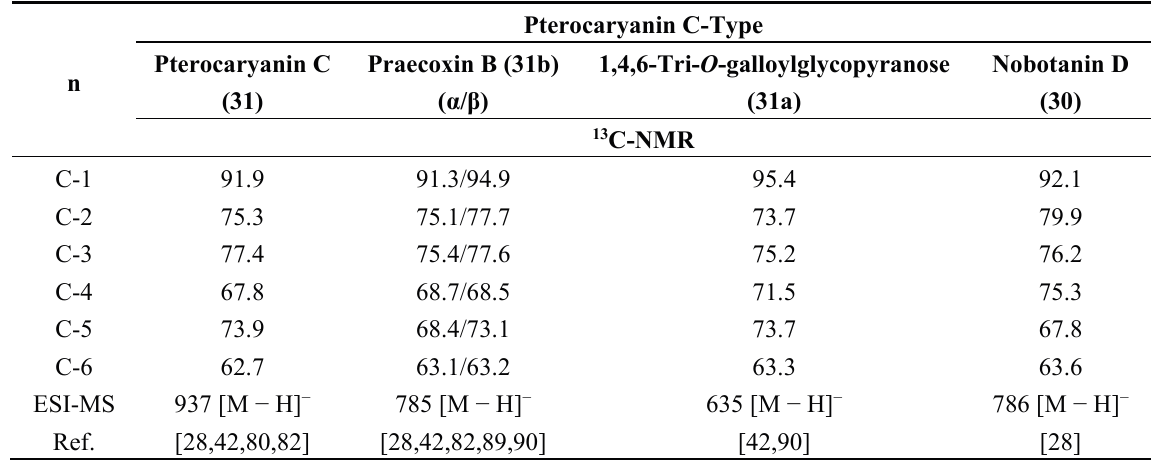
Table 3. 13 C-NMR and MS data of sugar moieties of pterocaryanin C type monomeric ellagitannins.